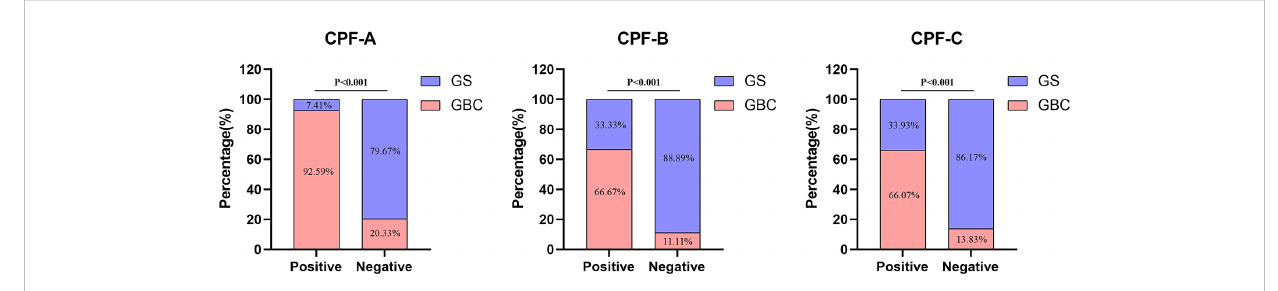
FIGURE 6 Diagnosis rate of CPF-A, CPF-B, and CPF-C in the external validation